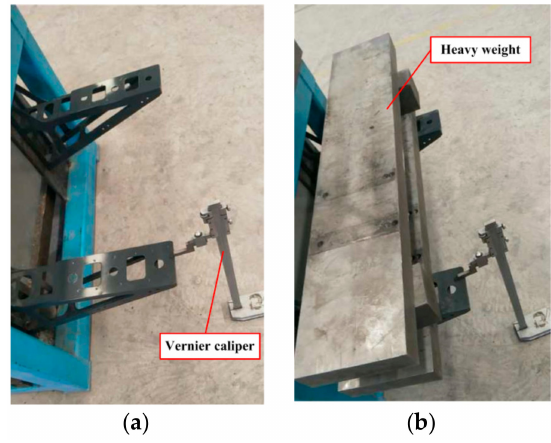
Figure 9. Sti ff ness check test. Seat bracket before ( a ) and after loading ( b